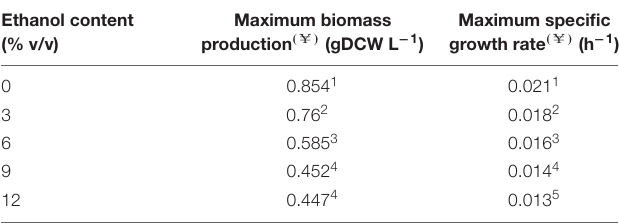
TABLE 1 | Maximum biomass production (gDCW L − 1 ) and maximum specific growth rates (h − 1 ) of O. oeni PSU-1 cultivated in MaxOeno defined medium with increasing concentrations of